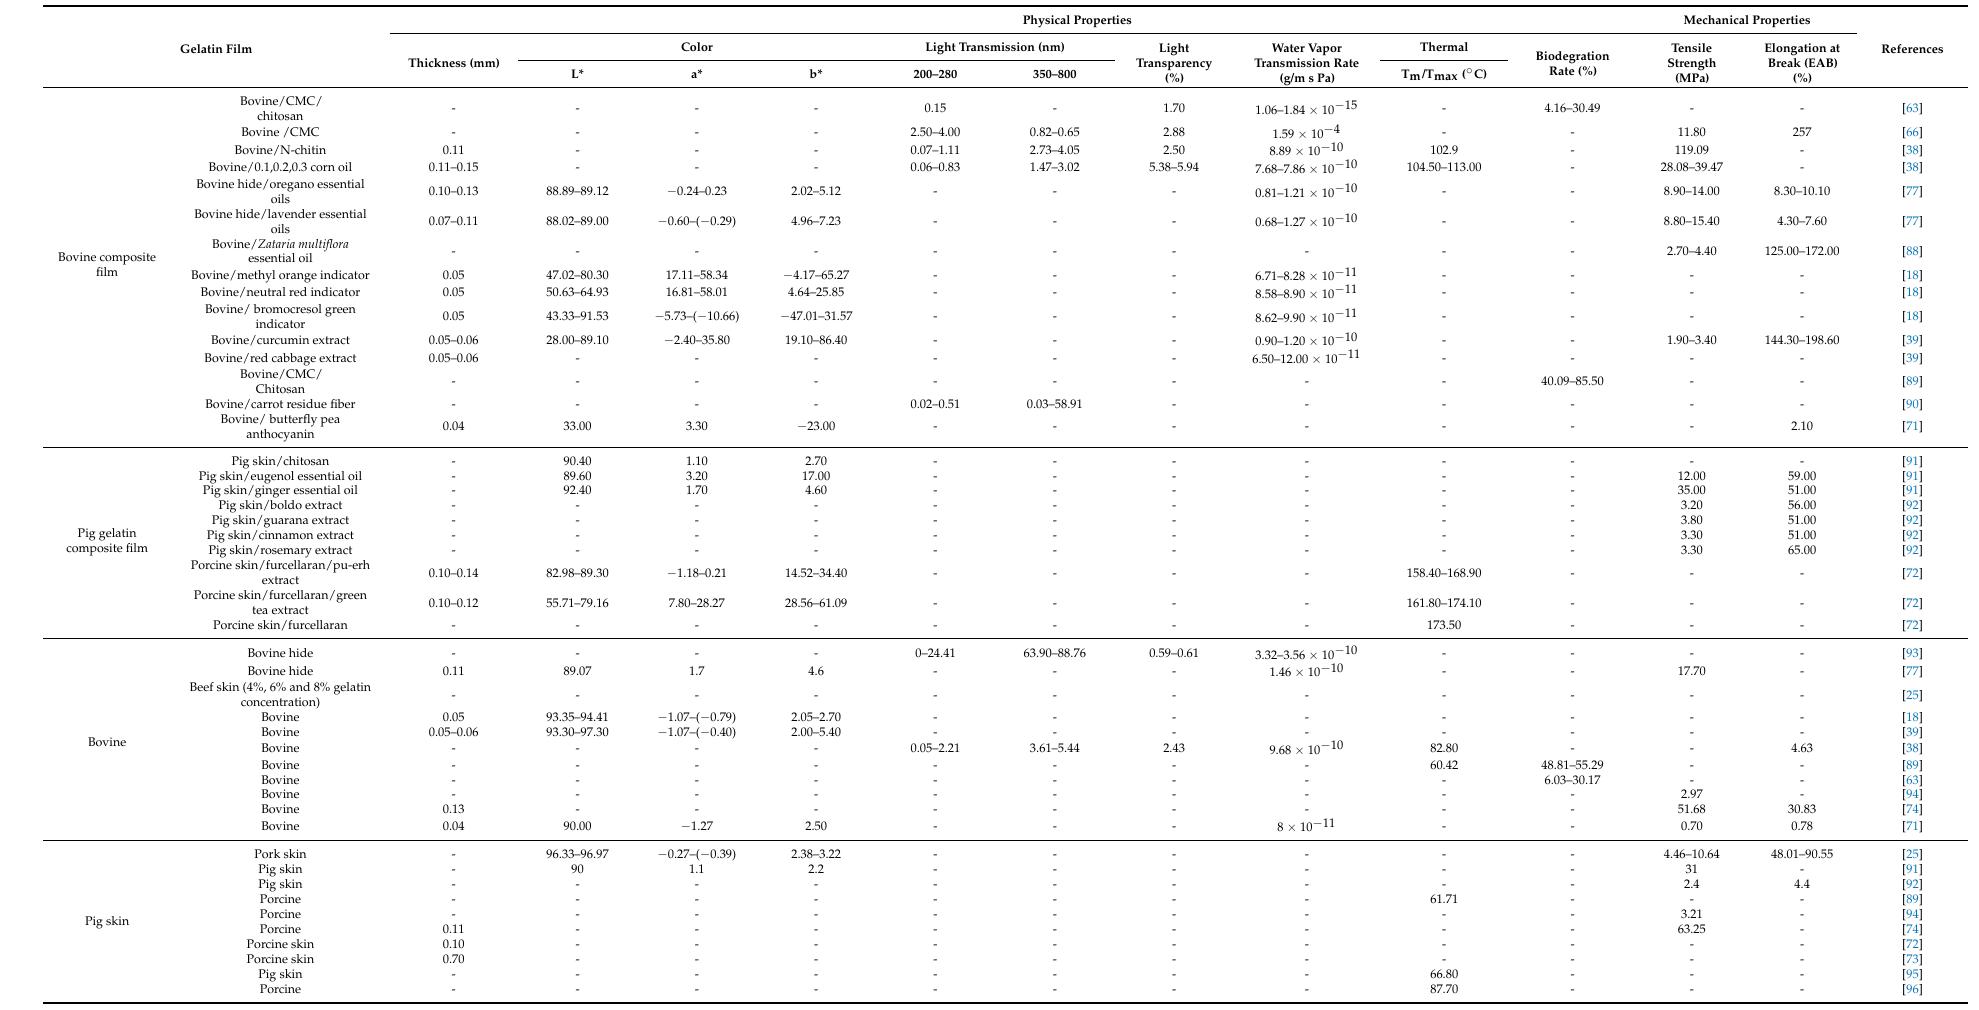
Table 1. Physical and mechanical properties of mammalian gelatin-based